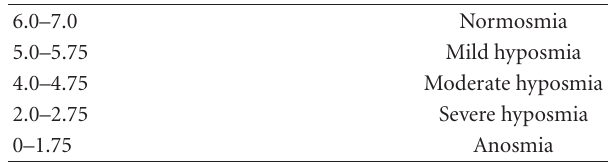
Table 1: CCCRC test